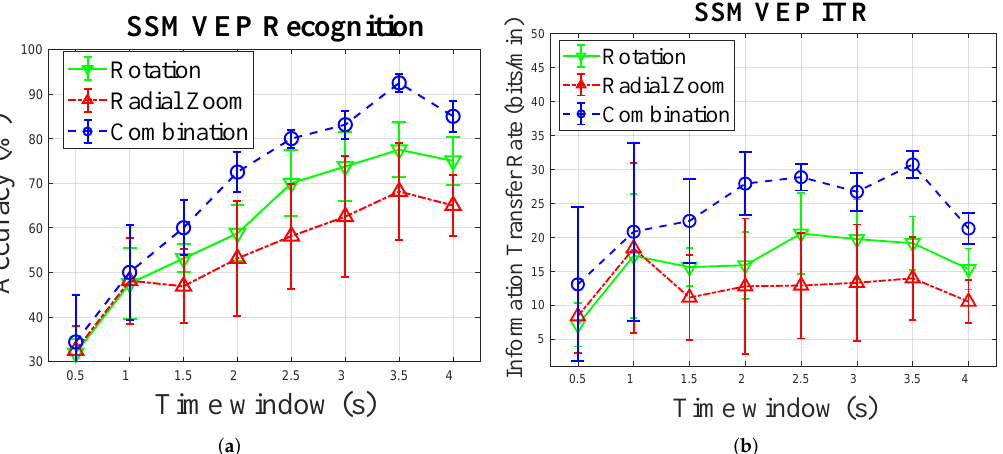
Figure 3. Mean and standard deviation across all subjects for each time window: ( a ) Accuracy comparisons. ( b ) ITR comparisons.